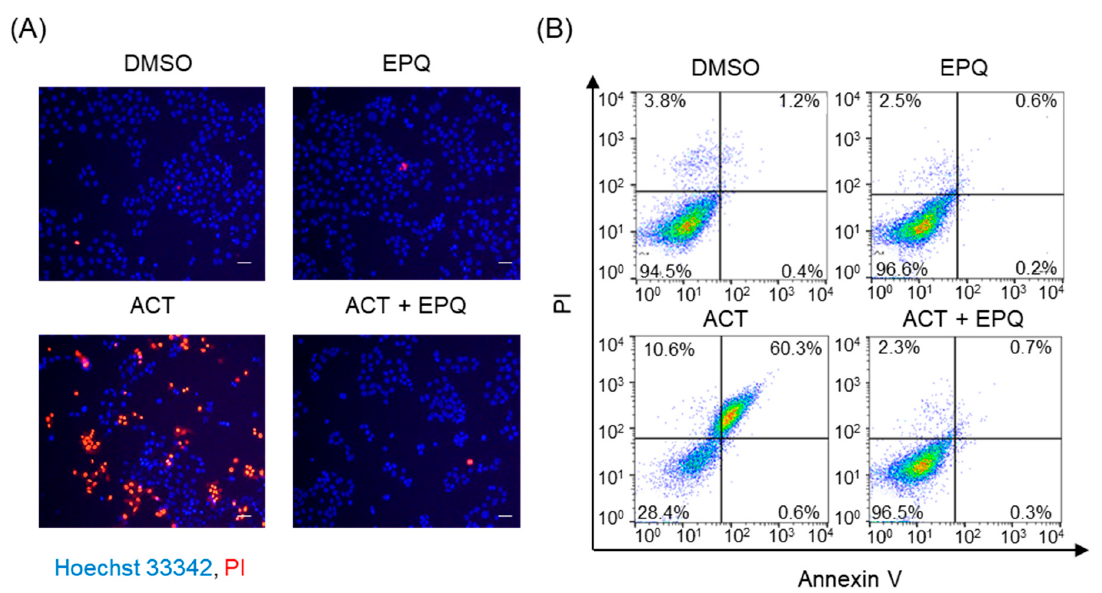
Figure 2. Inhibitory effects of EPQ on acetaldehyde-induced cytotoxicity in PC12 cells. ( A ) The effects of EPQ on the nuclear morphological changes of PC12 cells were observed by double staining with Hoechst 33342 (Blue) and propidium iodide (PI, Red). Cells were treated with DMSO (0.5%, v / v ) or EPQ (20 µ M) in the presence or absence of acetaldehyde (500 µ M) and observed under a fluorescence cell imaging system. Scale bar = 50 µ m. ( B ) Cells were treated with DMSO (0.5%, v / v ) or EPQ (20 µ M) in the presence or absence of acetaldehyde (500 µ M) for 24 h. Apoptotic cells were stained with annexin V and PI stains and analyzed using flow cytometry. ACT, acetaldehyde; EPQ, ent -peniciherqueinone; DMSO, dimethyl sulfoxide; PI, propidium iodide.